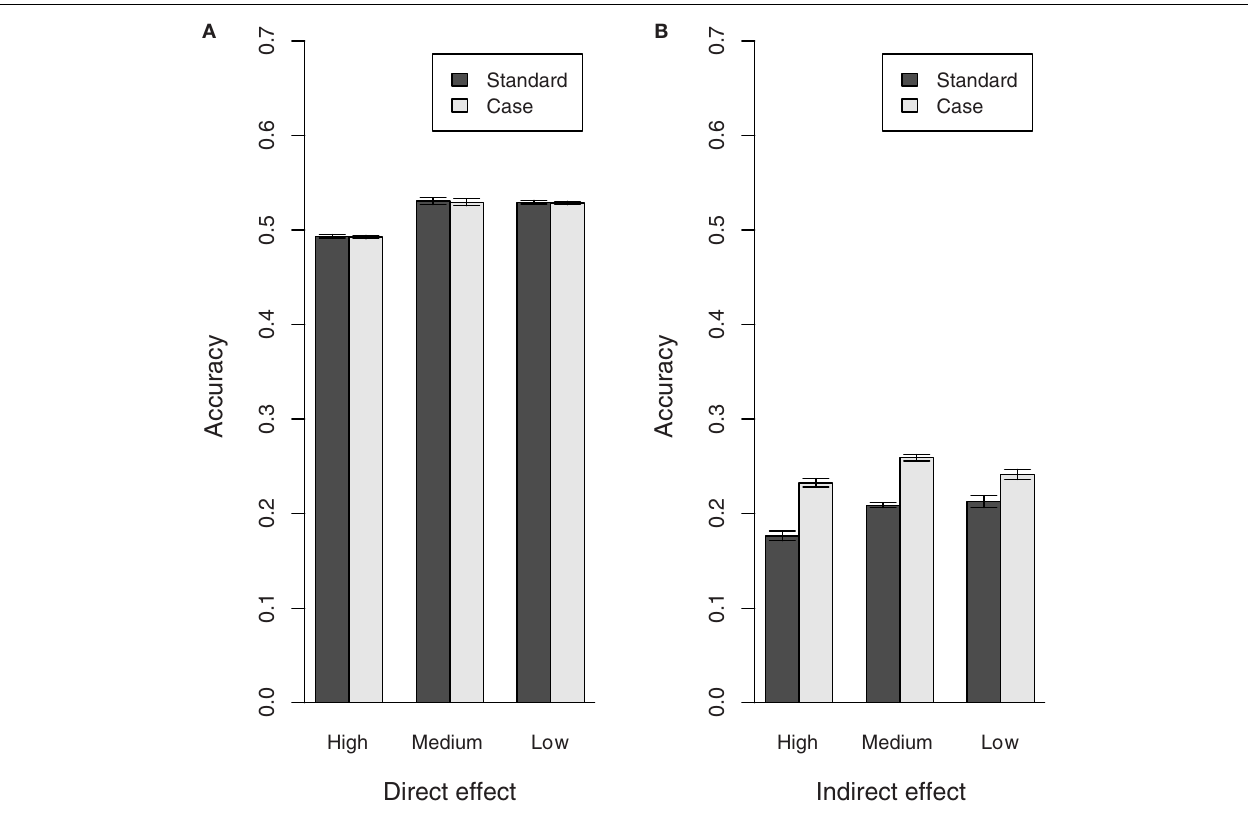
FIGURE 2 |Accuracy of direct and indirect effect BV estimates for populations with different recovery rates (High, Medium, and Low). (A) Direct effect, (B) indirect